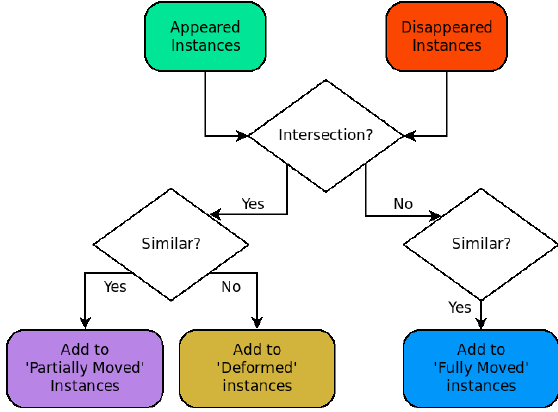
Figure 6. The case discrimination that is applied to determine the extended